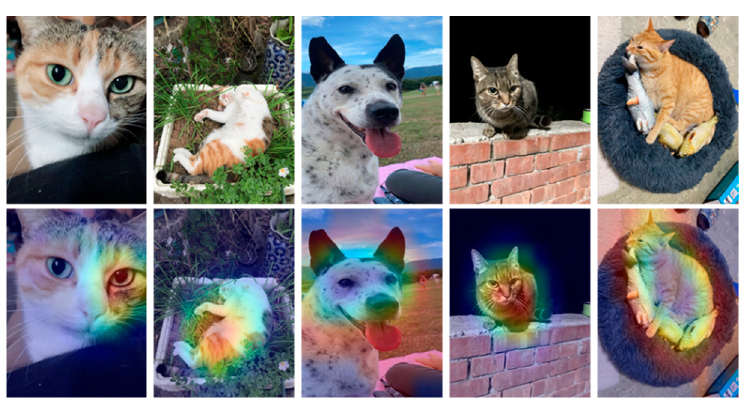
Figure 4. Examples of Grad-CAM.